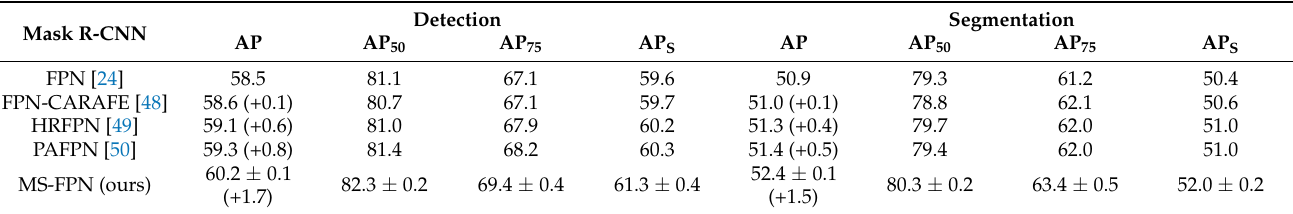
Table 1. The detection and segmentation performance of FPN, FPN-CARAFE, HRFPN, PAFPN, and the proposed MS-FPN model. Note that the MS-FPN experiment was repeated five times and the values represent the average ± standard